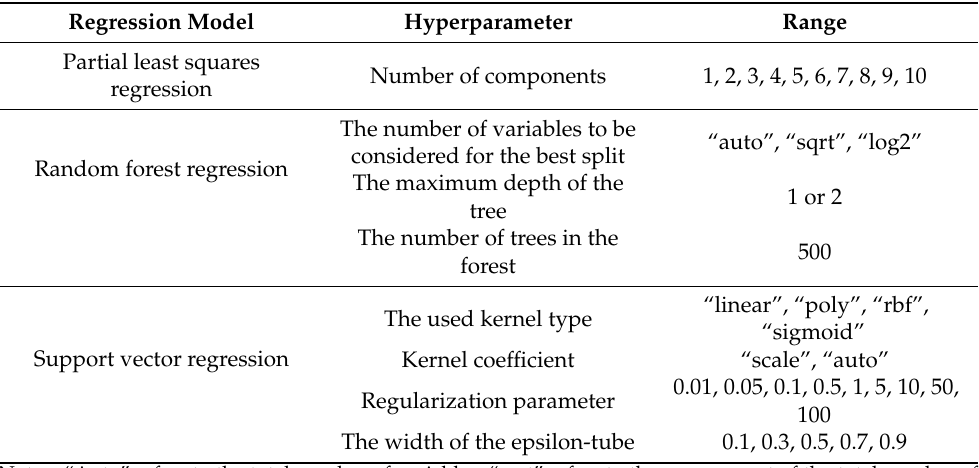
Table 5. The tuned hyperparameters and their ranges for each regression model. Regression Model Hyperparameter Range Partial least squares Number of components 1, 2, 3, 4, 5, 6, 7, 8, 9, 10 regression The number of variables to be “auto”, “sqrt”, considered for the best split Random forest regression